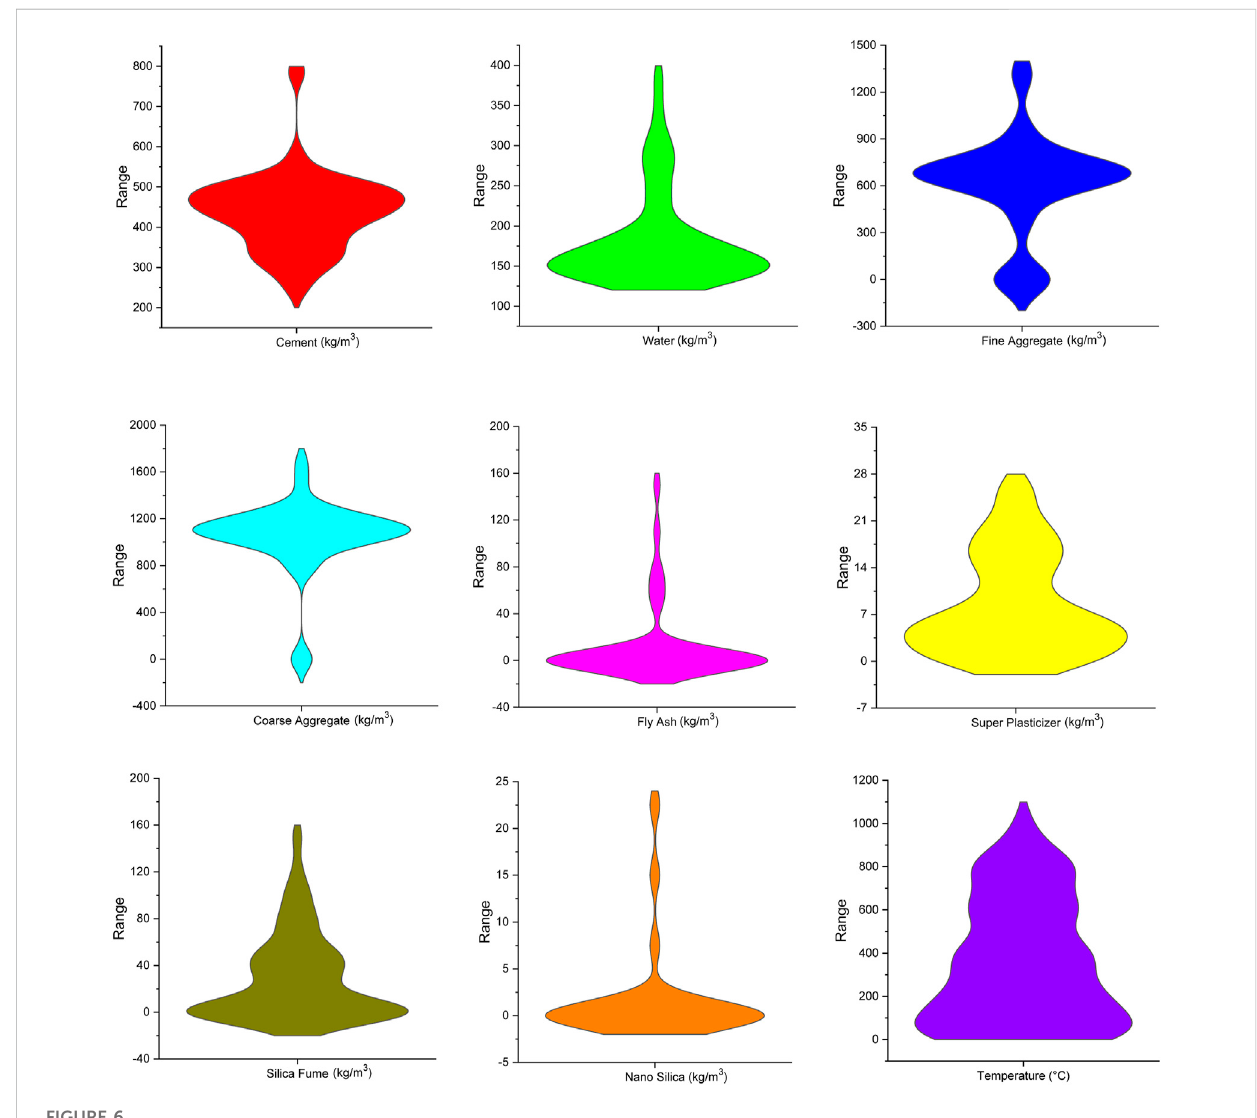
FIGURE 6 Input data parameter description.